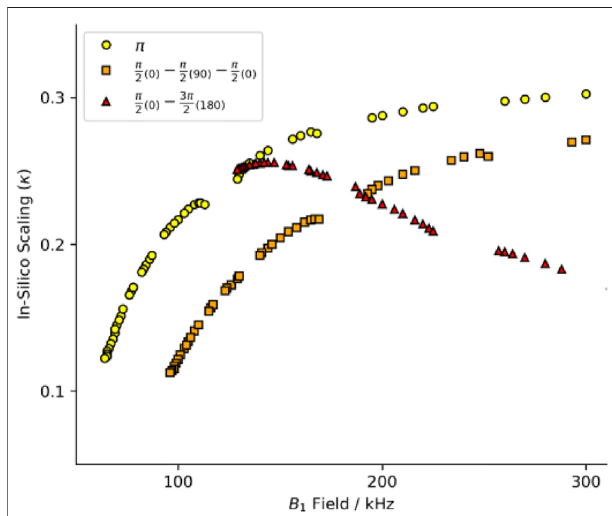
FIGURE 1 | Heteronuclear dipole-dipole recoupling scaling factor for symmetries found in Hou et al. (2011). The full range of symmetry match conditionsforstandardcompositepulses.Yellowcirclesarefor R -symmetries withastandard rectangular π pulse. Red trianglesreport thescaling with acompound R -elementofa π /2 (0) − π /2 (90) − π /2 (0) withtheequivalentmatchofa 3 π /2 pulse. Orange squares report the scaling with a compound R -element of a π /2 (0) − 3 π /2 (180) with the equivalent match of a 2 π pulse. See Supplementary Figure S1 for full B 1